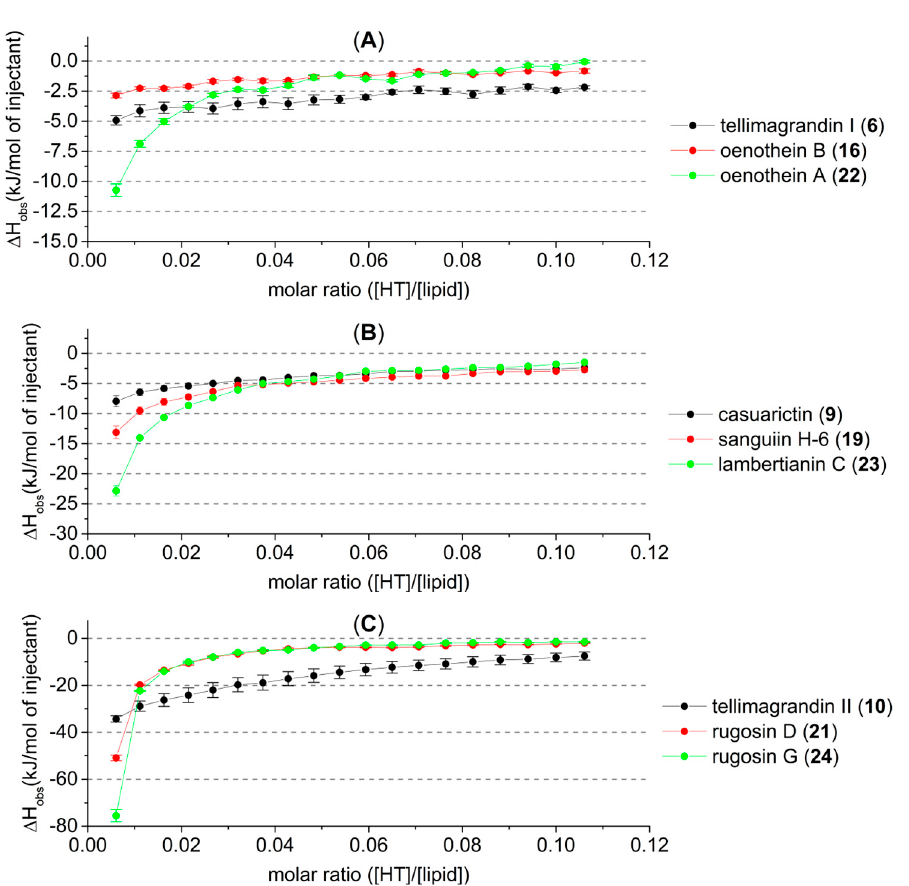
Figure 4. Observed heat rates of injection of three oligomeric series of hydrolysable tannins (HTs) as a function of the molar ratio ([HT]/[lipid]) in the sample cell. Heat rates are presented as kJ/mol of injectant with average values and standard error, n = 3. Monomer is presented in black, the dimer in red, and the trimer in green. These oligomeric series are formed from ( A ) tellimagrandin I ( 6 ), ( B ) casuarictin ( 9 ), and ( C ) tellimagrandin II ( 10 ) ‐ type monomeric constituents. For HT structures, refer to Figures 1 and 2.